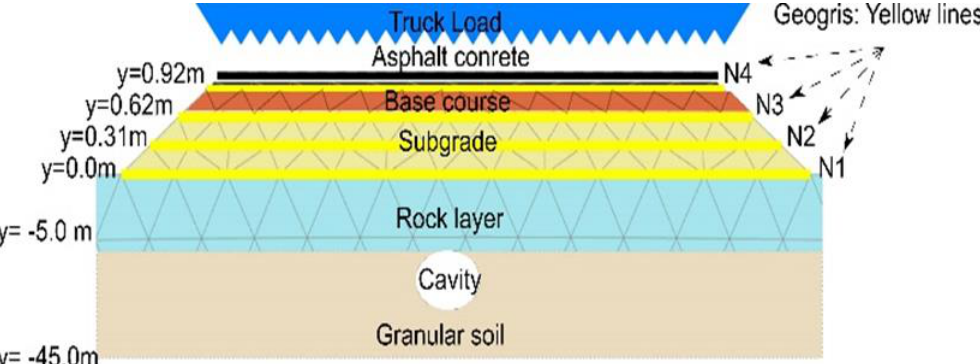
Figure 6. Karst terrain with the road structure and the location of the four geogrids - N 1 , N 2 , N 3 and N